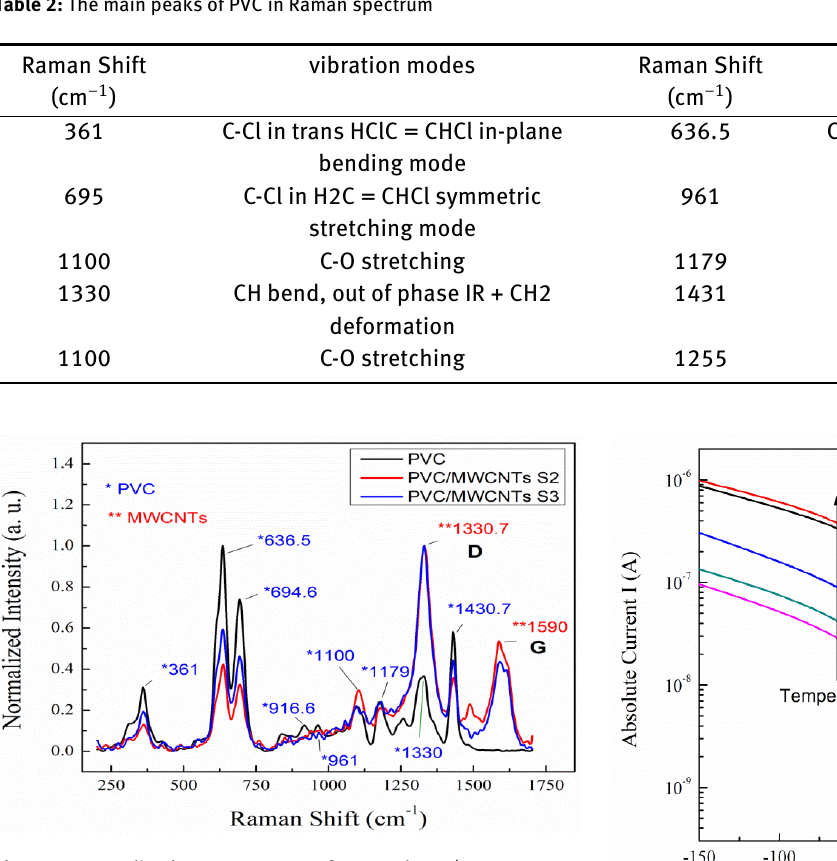
Figure 2: Normalized Raman spectra of PVC and PVC/MWCNTs nanocomposite